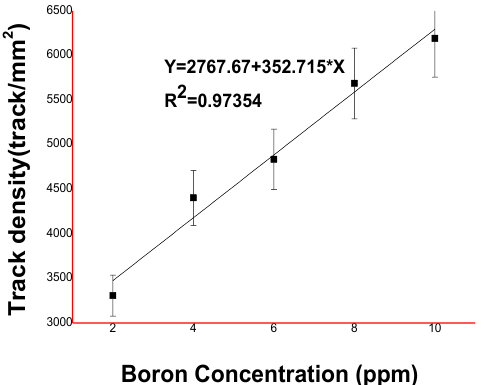
Fig. 4. Relationship between track density and Boron content (ppm), in typical Boron